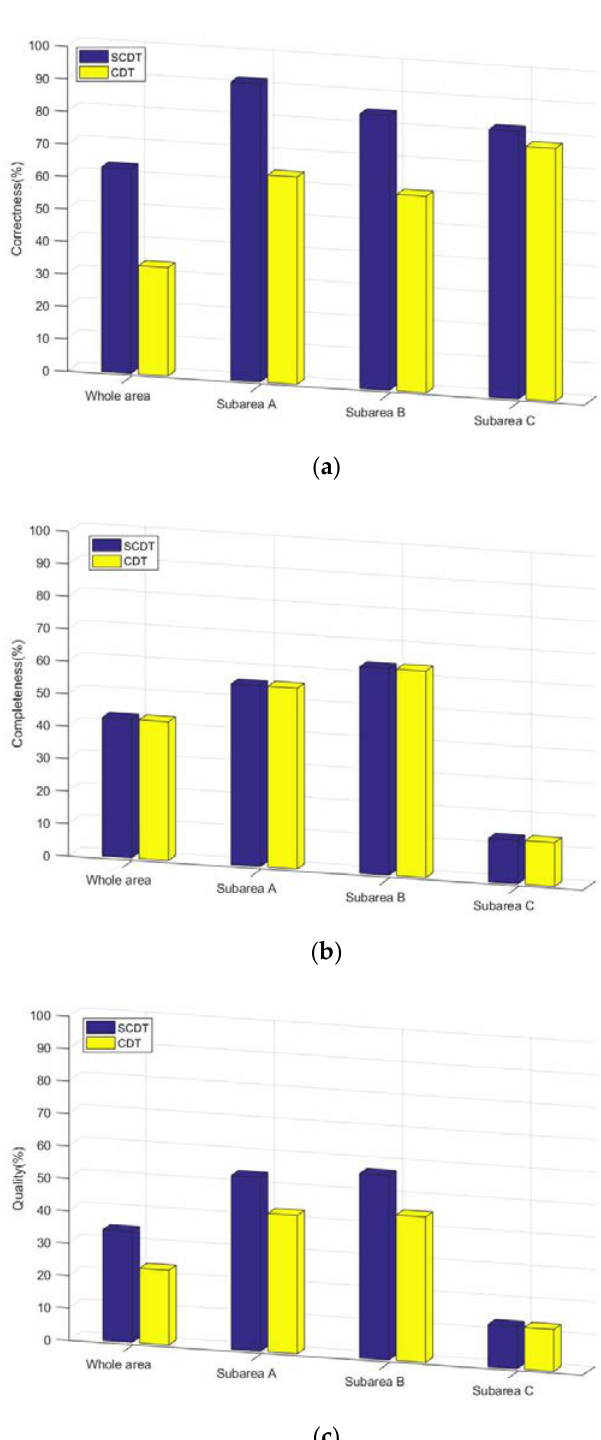
Figure 19. Quantitative evaluation results for the whole study area and the 3 sub-areas (A to C) for ( a ) Completeness, ( b ) Correctness and ( c )